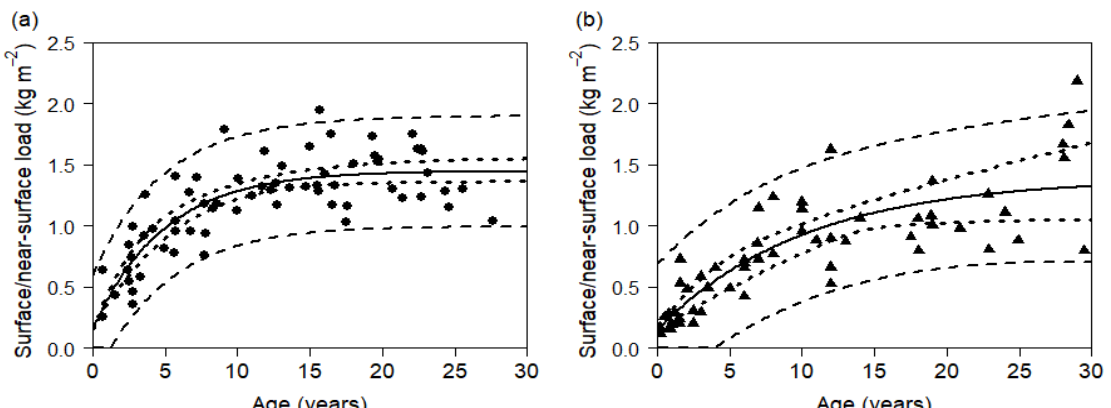
Figure 4. Modelled surface/near-surface fuel load accumulation curves (solid lines) with confidence bands (dotted lines) and prediction bands for new sites (dashed lines). ( a ) NE sites; ( b ) SE sites.